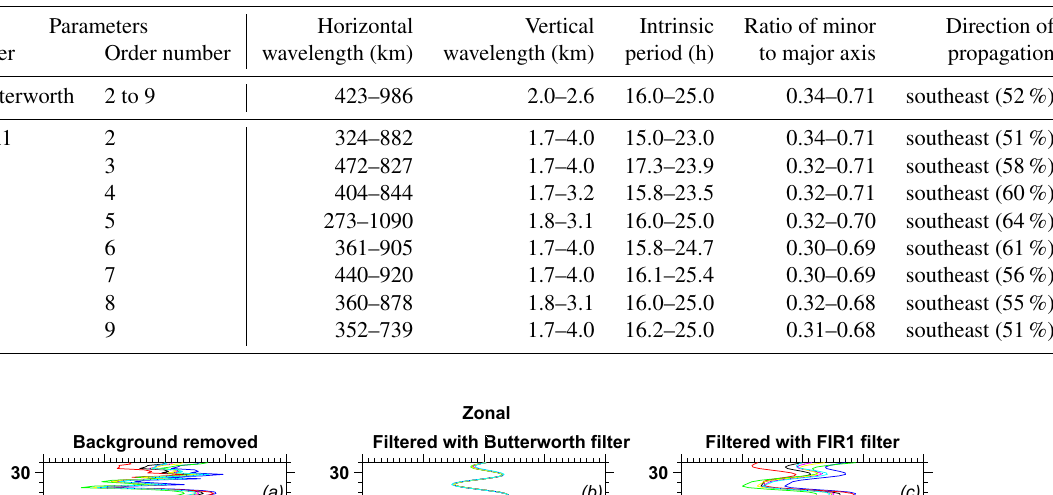
Table 2. Comparison of IGW parameters using an individual set of wind fluctuation profiles by removing the backgrounds with different order polynomial fits and using both the filters.